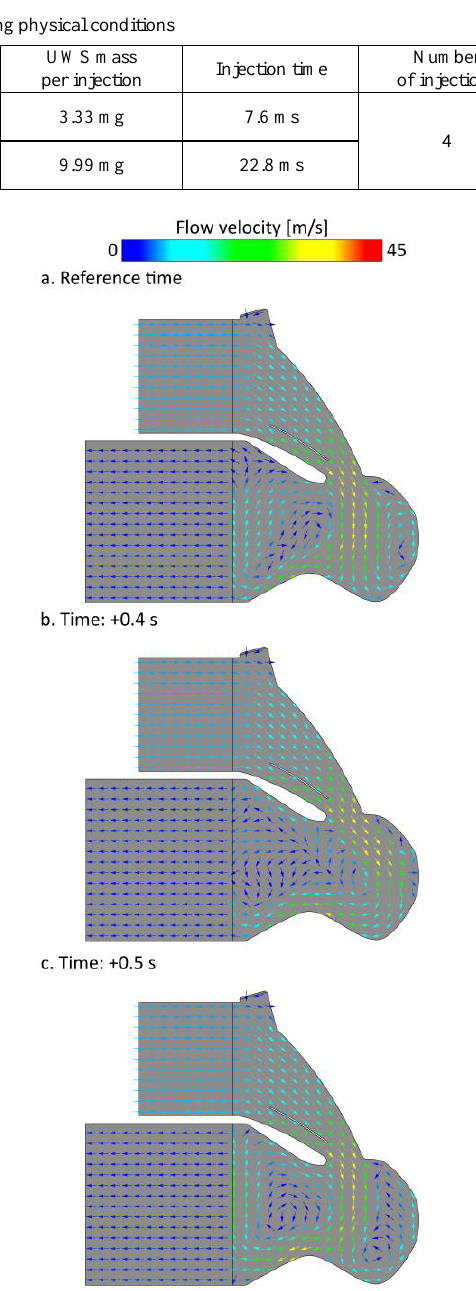
Fig. 3. Velocity fluctuations presented by flow velocity vectors – three particular layouts, mass flow rate: 300